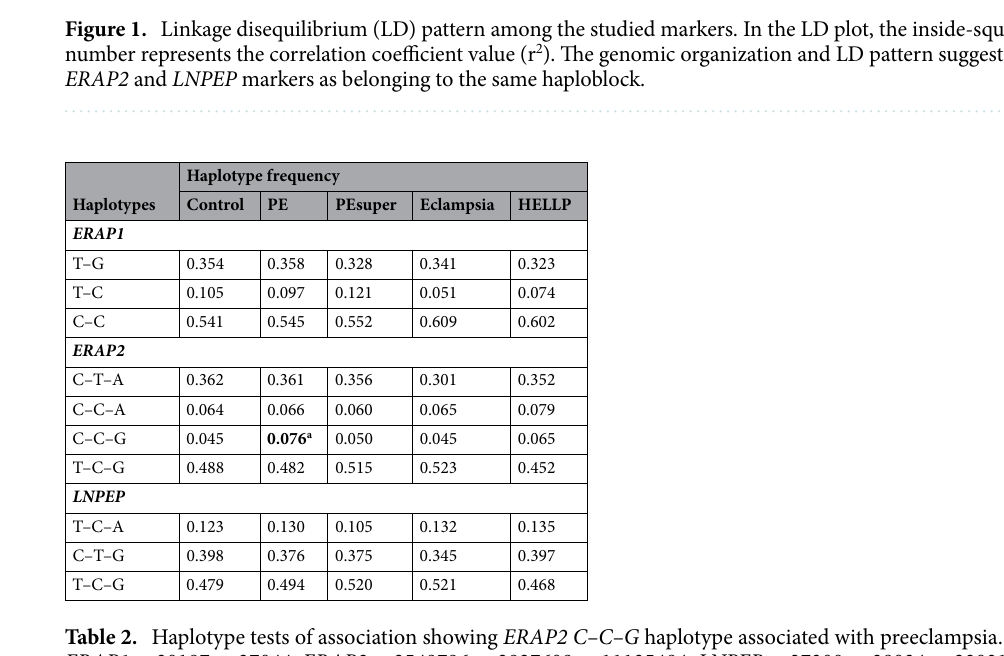
Table 2. Haplotype tests of association showing ERAP2 C–C–G haplotype associated with preeclampsia. ERAP1 : rs30187–rs27044. ERAP2 : rs2549796–rs2927609–rs11135484. LNPEP : rs27300–rs38034–rs2303138. a PE versus Control (Uncorrected p = 0.0013; p -value corrected for family-wise error rates by running 10,000 permutations: p = 0.0109).